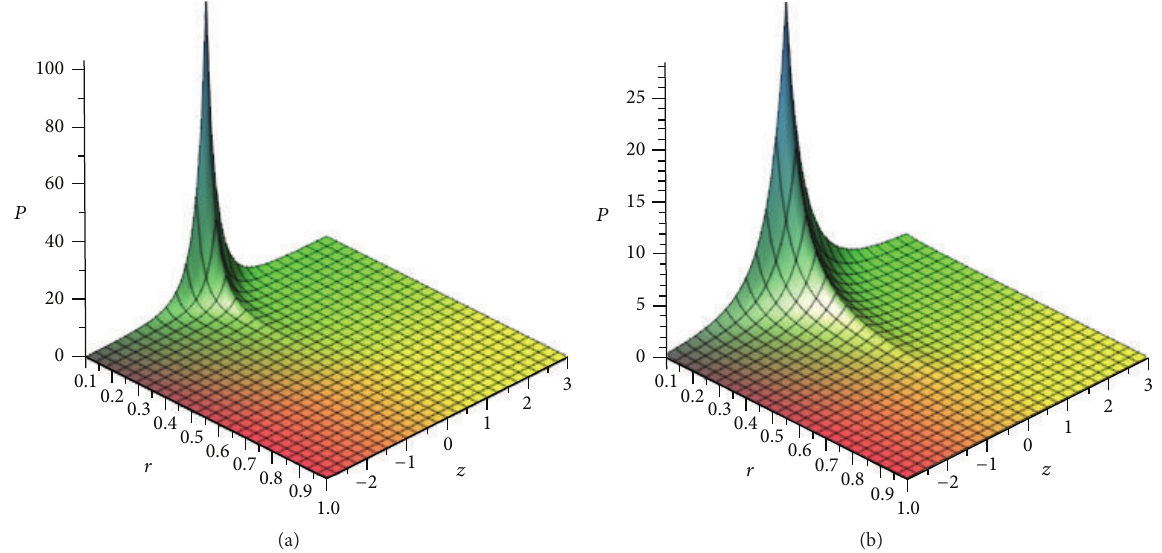
Figure 2: Surface plots of the pressures (a) 𝑃 ± 0 and (b) 𝑃 ± 1 on the halo as functions depending on 𝑟 and 𝑧 with parameters 𝑎 = 𝑏 0 = 𝑏 1 = 𝑘 = = 1 and 𝛽 = 0.75 𝑘 𝜔